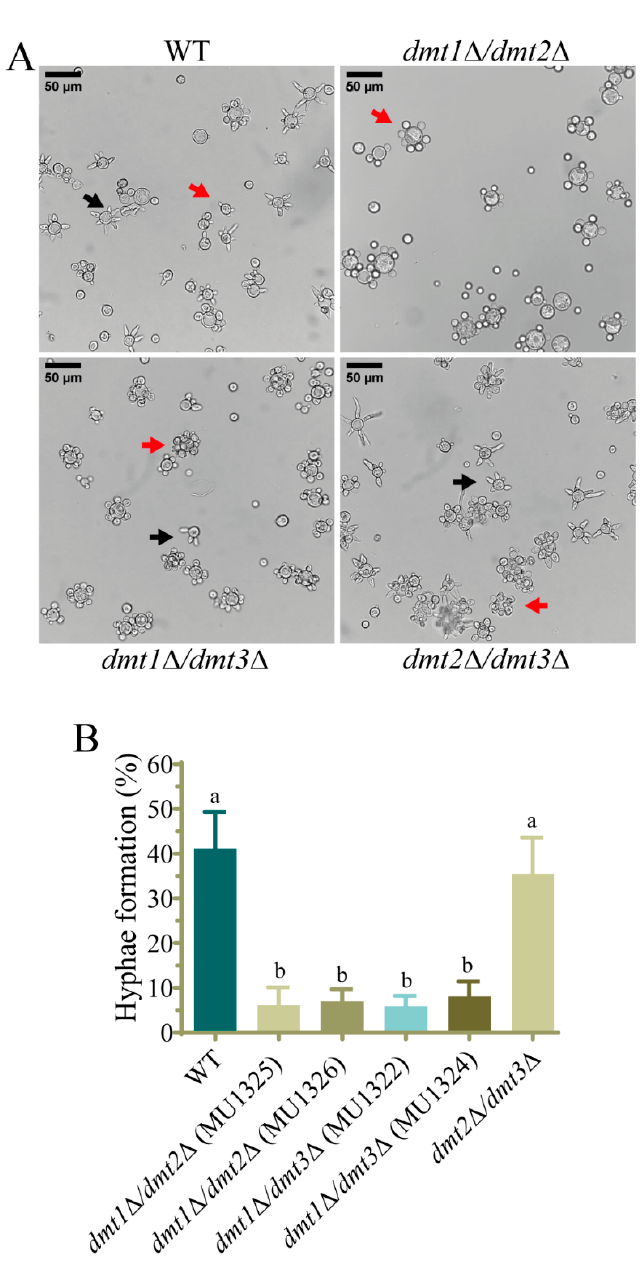
Figure 2. The double mutants having dmt1 deletion were affected in the hyphae emergence during yeast to mycelium transition. ( A ) Cells of wild-type strain CBS277.49 (WT), dmt1 Δ / dmt2 Δ (MU1325 and MU1326), dmt1 Δ / dmt3 Δ (MU1322 and MU1324), and dmt2 Δ / dmt3 Δ (MU1330) 2.5 h of growth after induction of hyphae formation by transferring to aerobic conditions. The arrows indicate the multi-budded yeasts (red) and cells with hyphae (black). ( B ) Percentage of yeasts with developed hyphae in wild type strain (CBS277.49) and the indicated double knockout mutants calculated from 200 total cells. The charts display means ± SD. Different letters above the bars indicate statistically significant differences, while the identical letters denote no statistical differences calculated using one-way ANOVA ( p < 0.001, Tukey test). Three independent experiments were conducted for each strain.